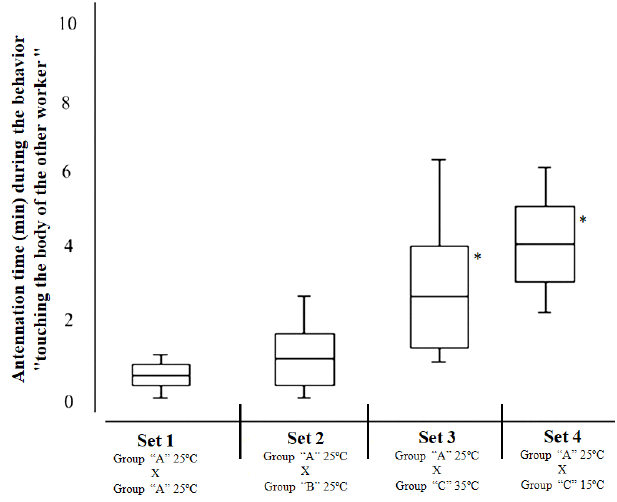
Fig 3. Median and standard deviation values for the antennation times measured during the behaviour “touching the body of the other worker”, for encounters between Odontomachus brunneus workers previously maintained under different temperature conditions (n =